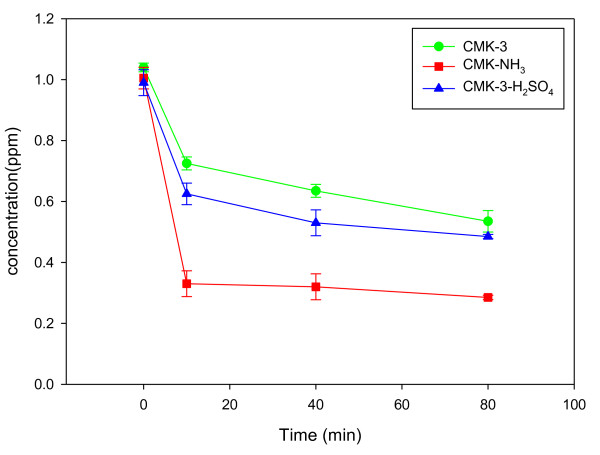
Adsorption of formaldehyde over CMK-3, CMK-3-H2SO4, and CMK-3-NH3 samples.